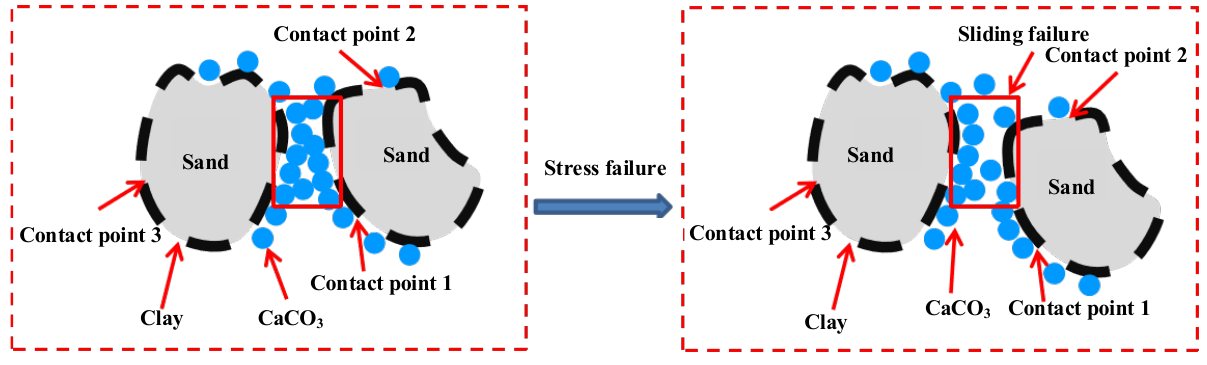
Figure 10. Diagram of sand-clay-CaCO 3 contact.